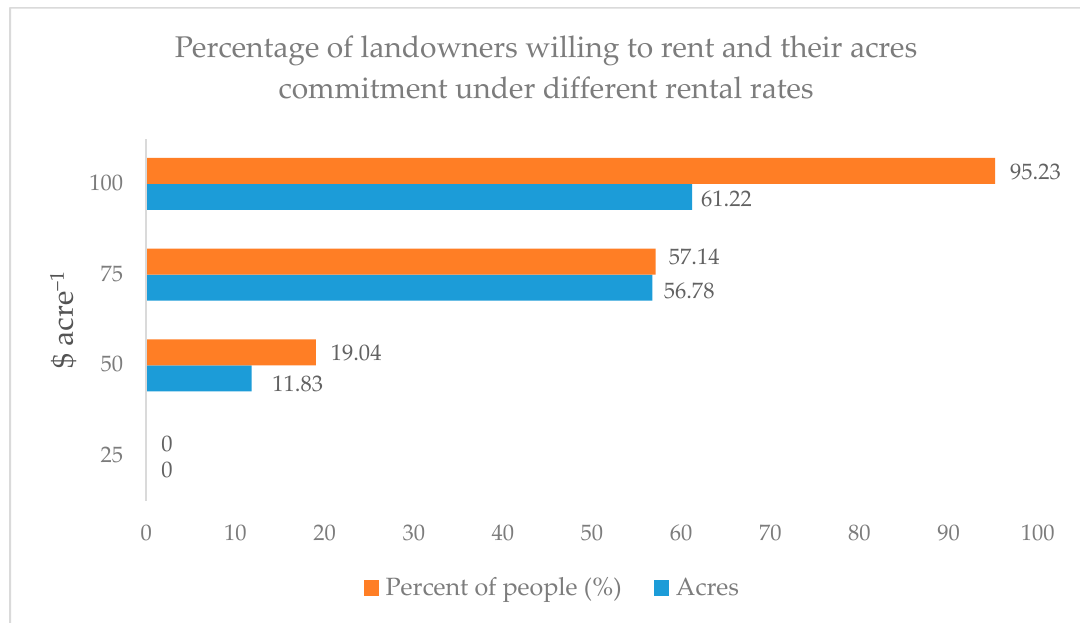
Figure 3. Percentage of landowners willing to rent their land and their acres commitment.